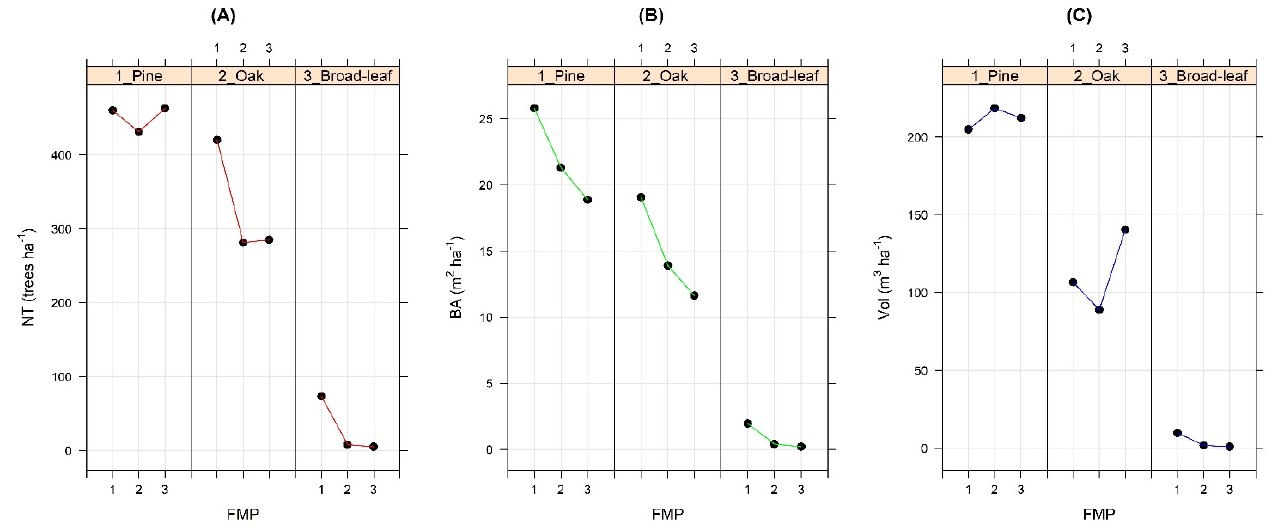
Figure 7. Comparison of number of trees (NT) ( A ), basal area (BA) ( B ), and volume (Vol) ( C ) of the three forest management plans (FMPs) in the L0107 sub-stand.